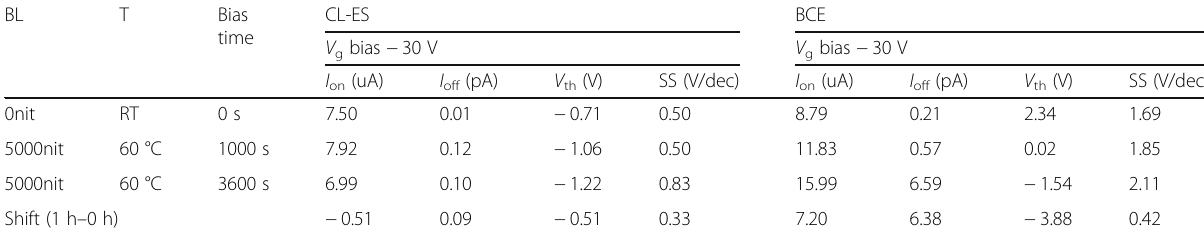
Table 2 The on-current shift, off-current shift, and subthreshold voltage swing variance values of CL-ES-structured device and BCE- structured